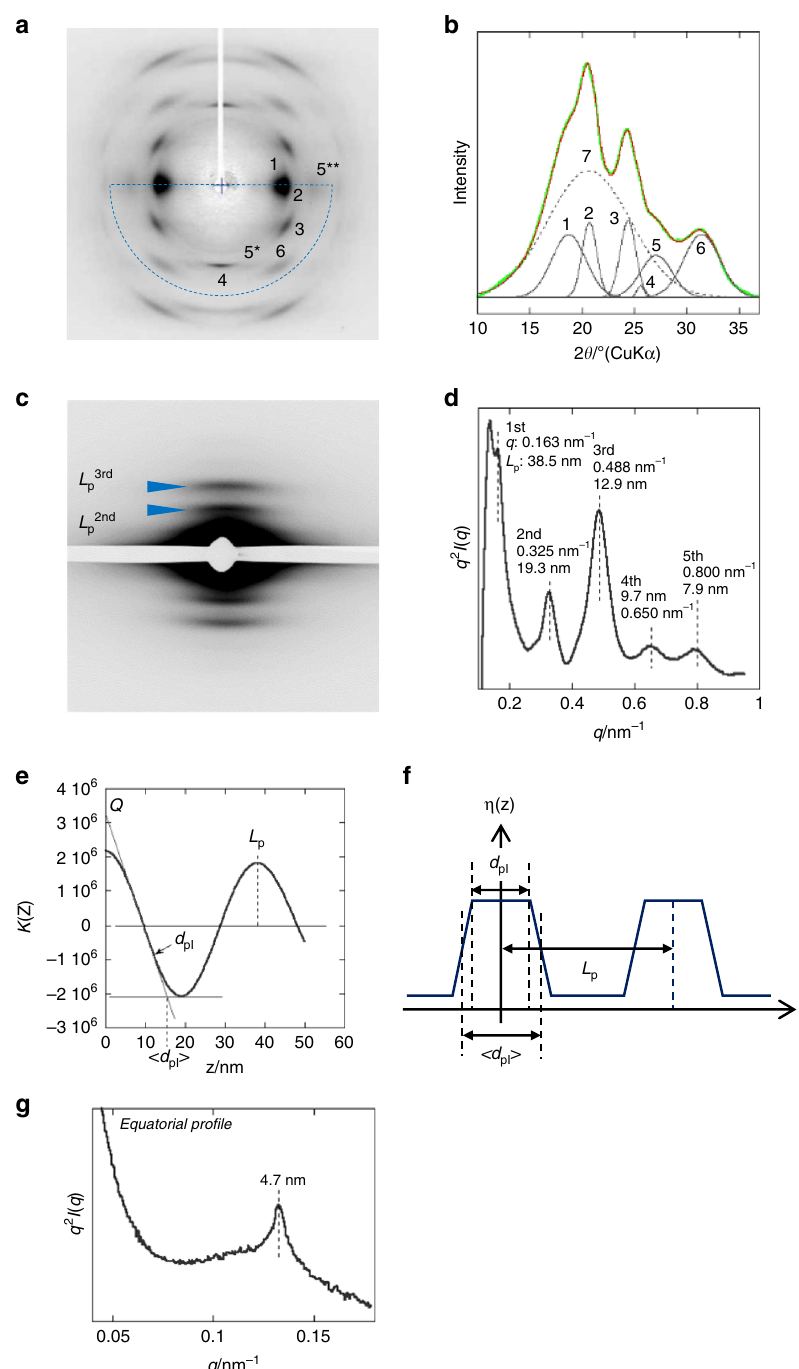
Fig. 3 Structural information of the bagworm silk. a WAXD fi bre diagram obtained from the bagworm silk and b its 2 θ pro fi le scanned in the 2 θ range from 10° to 37°, and for the azimuthal angle range from 0° to − 180°, which is enclosed by the broken blue line in a . The crystallinity was evaluated from the 2 θ pro fi le by peak fi tting. Each peak number corresponds to the following. 1: (200) crystalline re fl ection, 2: (210), 3: (211), 4: (002), 5: (102)* + (300)**, 6: (202), and 7: amorphous peak. The peak fi tting was performed using the spectroscopy software Grams Suite 9.3 (Thermo Fisher Scienti fi c Inc., USA) by fi xing the peak positions for the crystalline re fl ections at ~1 – 6. c Synchrotron SAXS pattern and d its meridional q -pro fi le ( q 2 I ( q) vs. q Kratky plot). To avoid beam damage of the detector due to the strong equatorial-streak scattering, a narrow metal plate was attached on the detector surface along the equatorial line, and it appears as the white gap running along the equatorial line in the SAXS pattern c . e The electron density correlation function K ( z ) and f the corresponding electron density distribution η ( z ), for the repeating phases. Q , L p , d pI , and 〈 d pI 〉 denote the invariant, long period (phase I + II), core thickness of phase I, and mean thickness of phase I, respectively. The L p , d pI , and 〈 d pI 〉 were estimated to be 38.2, 12.5, and 15.7 nm, respectively. g Equatorial SAXS q - pro fi le ( q 2 I ( q ) vs. q Kratky plot) scanned from the 2D pattern shown in Supplementary Fig.